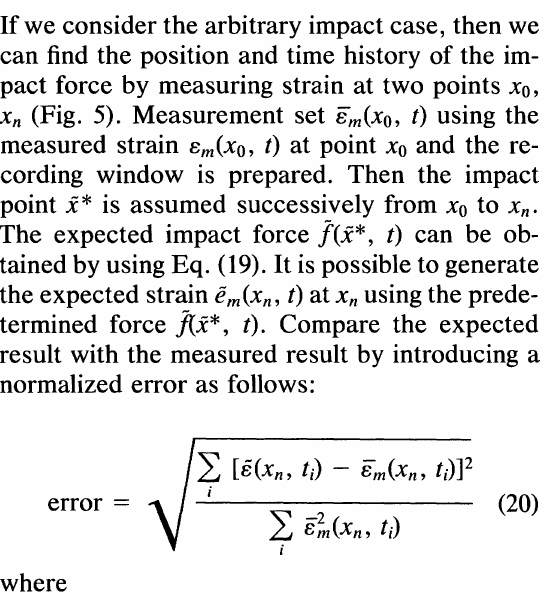
FIGURE 5 Arbitrary impact and measurement point.